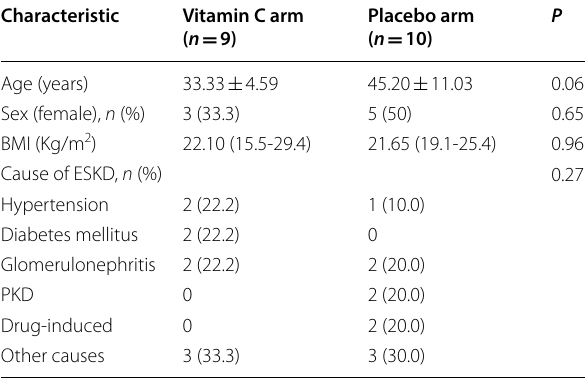
Table 1 Demographic information of transplant